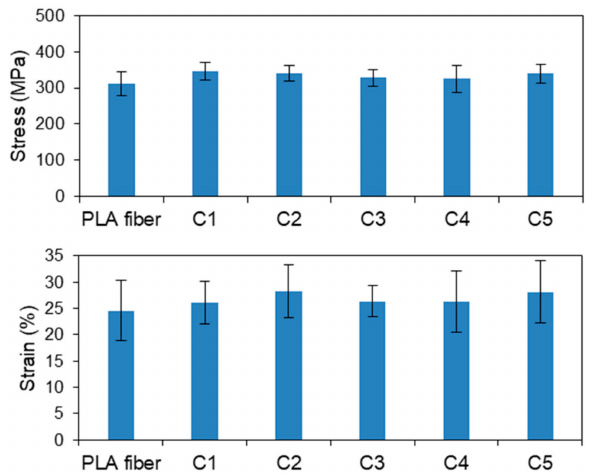
Figure 3. Tensile stresses and strains of the CS-coated PLA fibers based on P1.